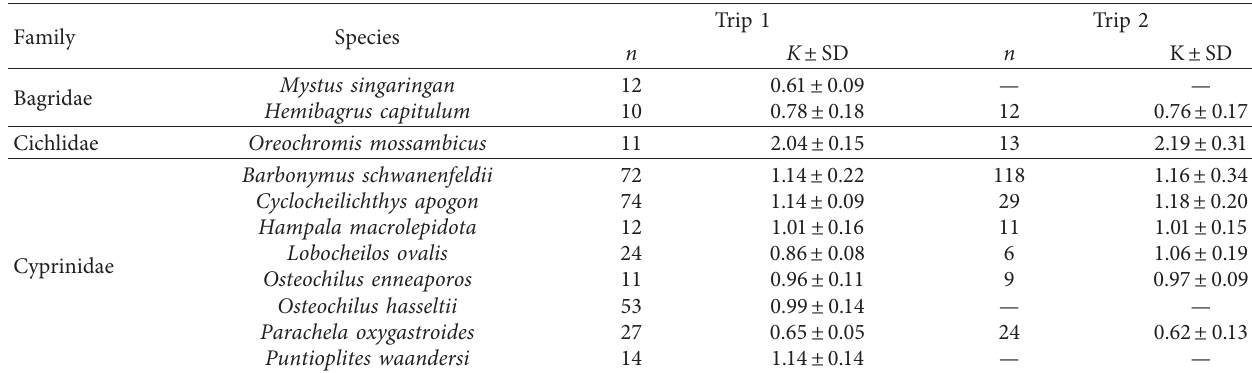
Table 6: The condition factor ( K ) of the selected species in the Murum River during dry (trip 1) and wet (trip 2) seasons. Family